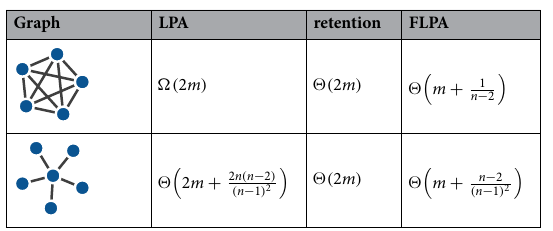
Table 1. Expected runtime complexity of LPA, its retention variant and FLPA for two theoretical graphs.